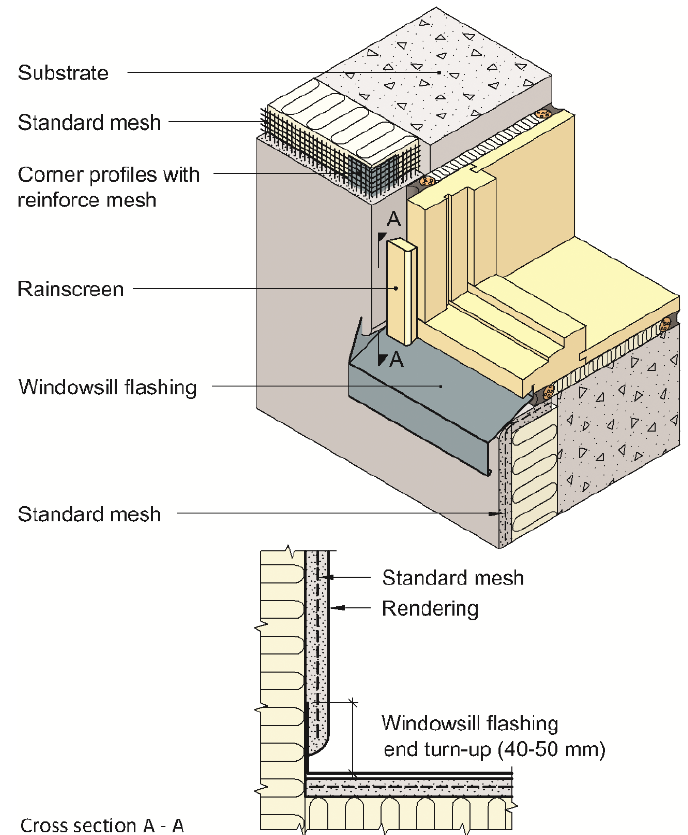
Figure 7. Recommended installation of window in a brick or concrete wall with ETICS. The flashing variant is adapted to the render system in question and is most applicable for render mortars based on organic binding agents (plastic).